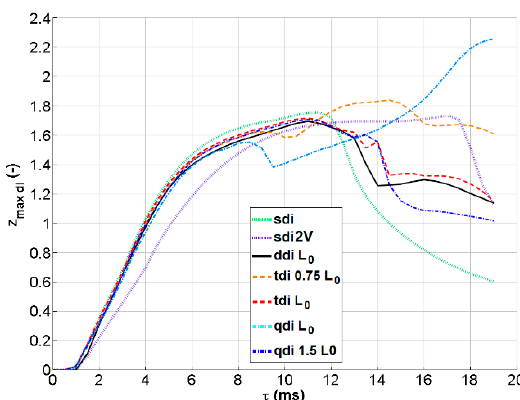
Figure 13. Dimensionless z max as a function of time from the numerical simulations for multiple drop impact cases (three drops, tdi, and four-drops, qdi) having w = 1.4 m/s and different inter-drop spacing. Results for single drop impacts for drops having the same volume (sdi) and two times the volume (sdi2V) are also added for comparison.